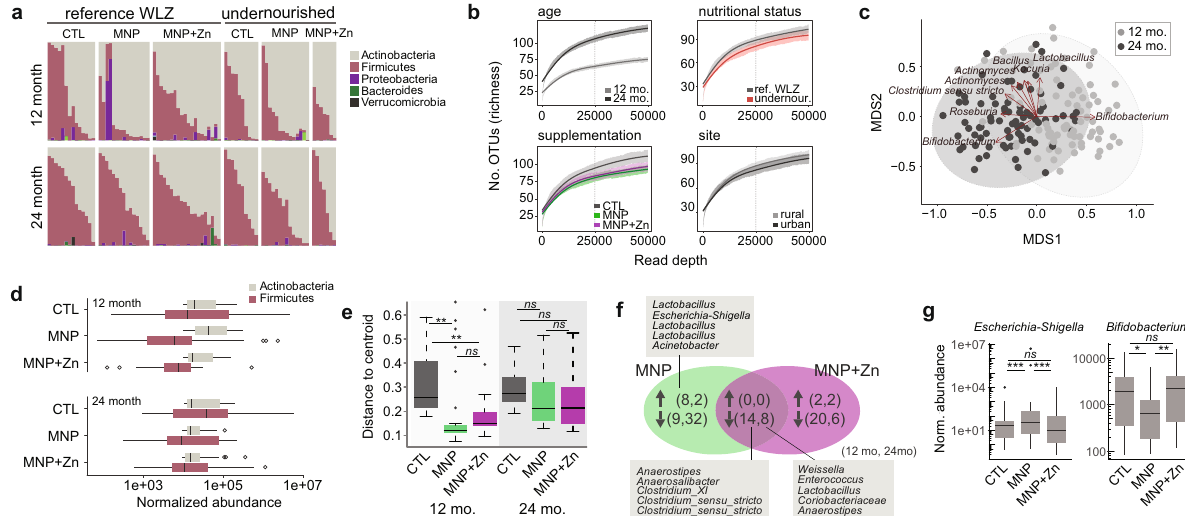
Fig. 3 Bacterial microbiota change with age and supplementation. a Relative abundances of bacterial phyla in 12 (top) and 24 (bottom) month old children based on 16S data. b Rarefaction curves comparing mean species richness by age, micronutrient supplementation, nutritional status, and place of residence (site). Shaded regions represent standard errors and the dotted lines denote the read depth at which signi fi cance was tested. c Non-metric multidimensional scaling of bacterial compositions based on Bray – Curtis dissimilarities. Samples are colored by age, and ellipses represent 95% con fi dence intervals. Arrows indicate the direction of increasing abundance of the top 10 bacterial OTUs signi fi cantly correlated with the ordination axes, scaled by their strength of correlation (r 2 ). d Mean DESeq2-transformed abundance of Actinobacteria and Firmicutes in samples ( n = 80) grouped by age and treatment. e Compositional variance among samples grouped by supplementation arm and age, based on weighted UniFrac dissimilarities and measured as distances to the centroid. Signi fi cance was tested using two-way ANOVA with the Tukey HSD post-hoc test ( n = 80, 12 months CTL vs MNP p = 0.0032, CTL vs MNP + Zn p = 0.0029) f Venn diagram shows numbers of bacterial taxa signi fi cantly increased or decreased in abundance, as indicated by arrows, in supplemented groups relative to the control. Numbers in brackets refer to taxa at 12 and 24 months of age. Select taxa are listed. g Normalized abundance of Escherichia – Shigella and Bi fi dobacterium OTUs across supplementation arms at 12 months ( n = 80). Signi fi cant differences were determined using the Wald test in DESeq2 and Benjamini – Hochberg multiple testing correction ( Escherichia – Shigella CTL vs MNP p = 2.6e-11, MNP vs MNP + Zn p = 7.1e-17; Bi fi dobacterium CTL vs MNP p = 0.029, MNP vs MNP + Zn p = 0.0064). Boxplots in d , e , and g represent medians and interquartile ranges (IQR), and whiskers demarcate 1.5x IQR. Asterisks in ( e and g ) are * p < 0.05, ** p < 0.01, ** *p < 0.001, ns not signi fi